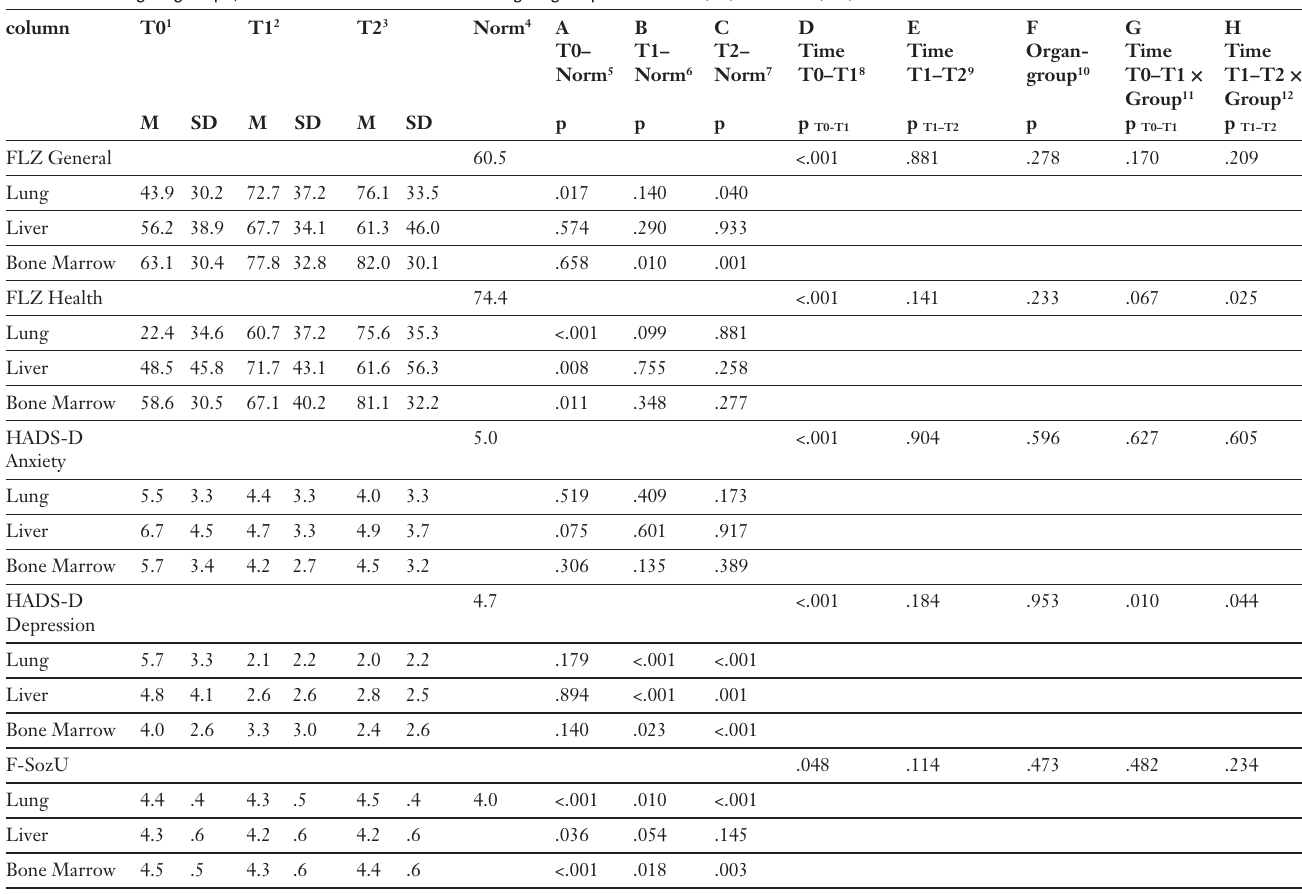
Mean values and standard deviations of the FLZ / HADS-D subscales and F-SozU scale before and after a lung, liver or bone marrow transplant (n = 76), differences compared to the norm values [46, 49, 50], differences over the course of time (T0/T1 und T1/T2) of all patients, differences between the organ groups, and differences between the organ groups over time (T0/T1 and T1/T2).